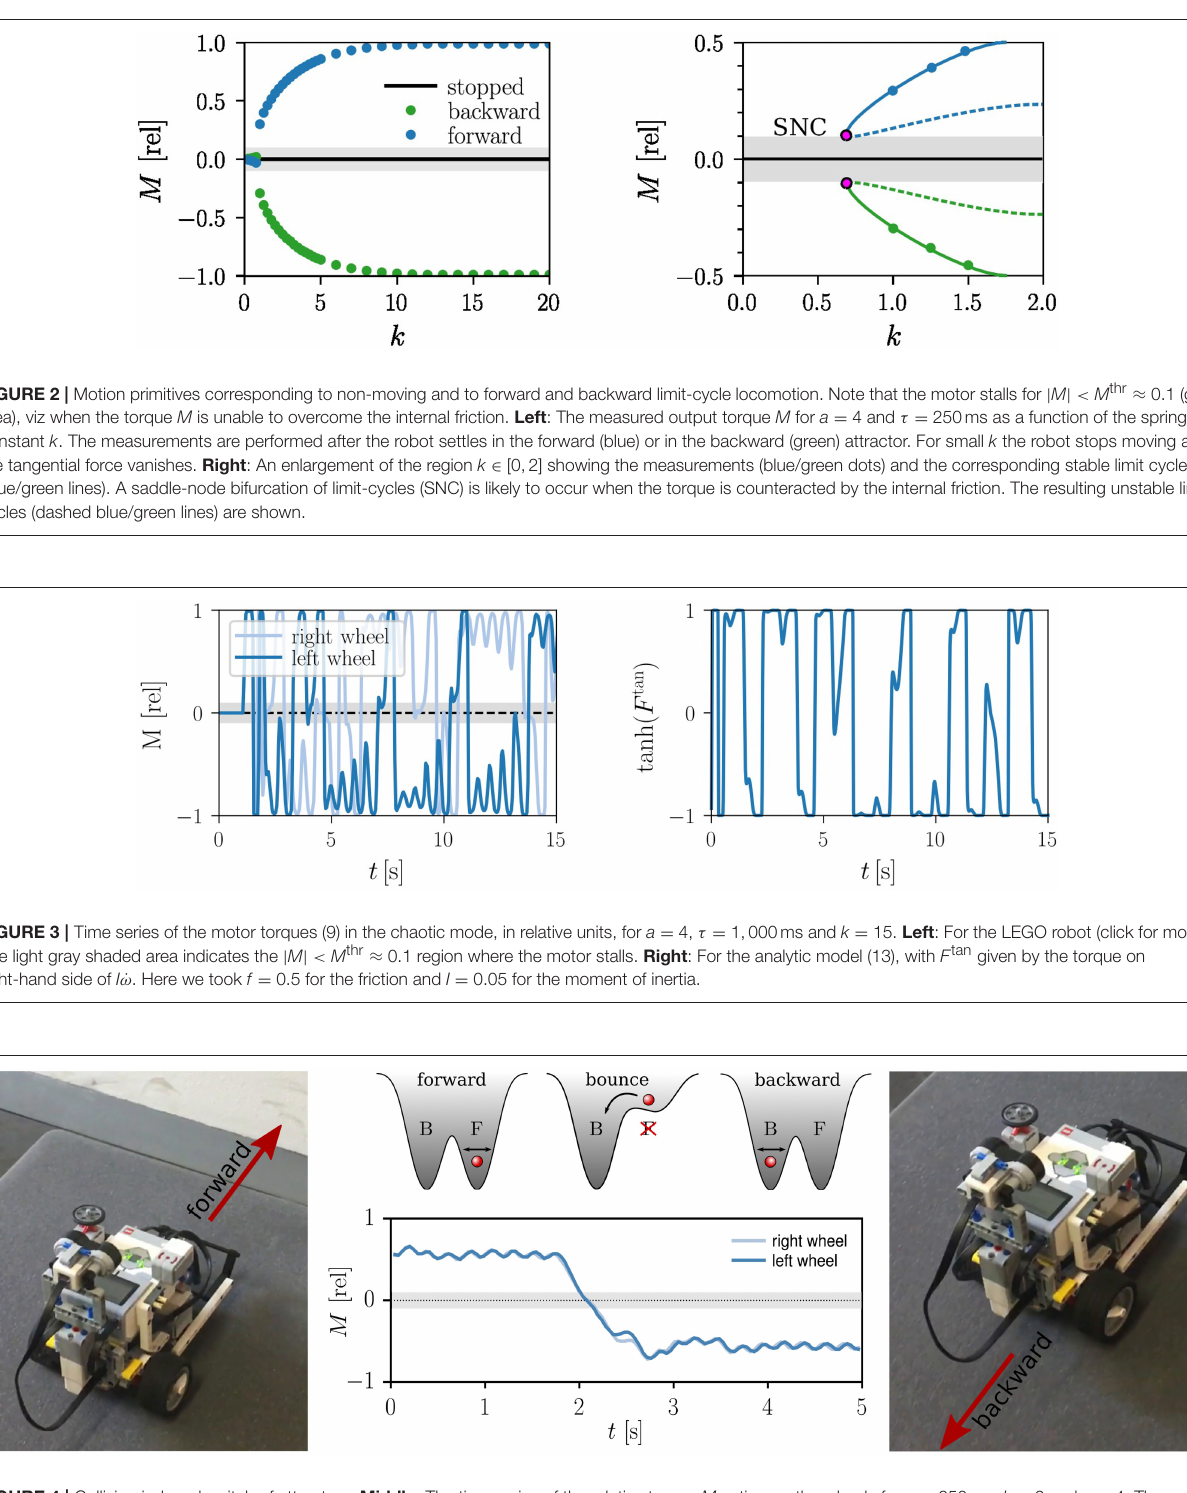
FIGURE 4 | Collision induced switch of attractors. Middle : The time series of the relative torque M acting on the wheels for τ = 250ms, k = 2 and a = 4. The gray shaded region indicates the minimal torque needed to start the motor, M thr = 0.1. The superimposed sketches illustrate a double-well potential with the minima corresponding to two coexisting attractors. The phase point (red ball) stays around the minima even in the presence of noise or small oscillations. The system is located in the backward attractor (B) when the robot collides with a wall and the forward attractor (F) is destabilized. The total torque M changes consequently its sign. Right, Left : The Lego robot before and after colliding with the wall (click for